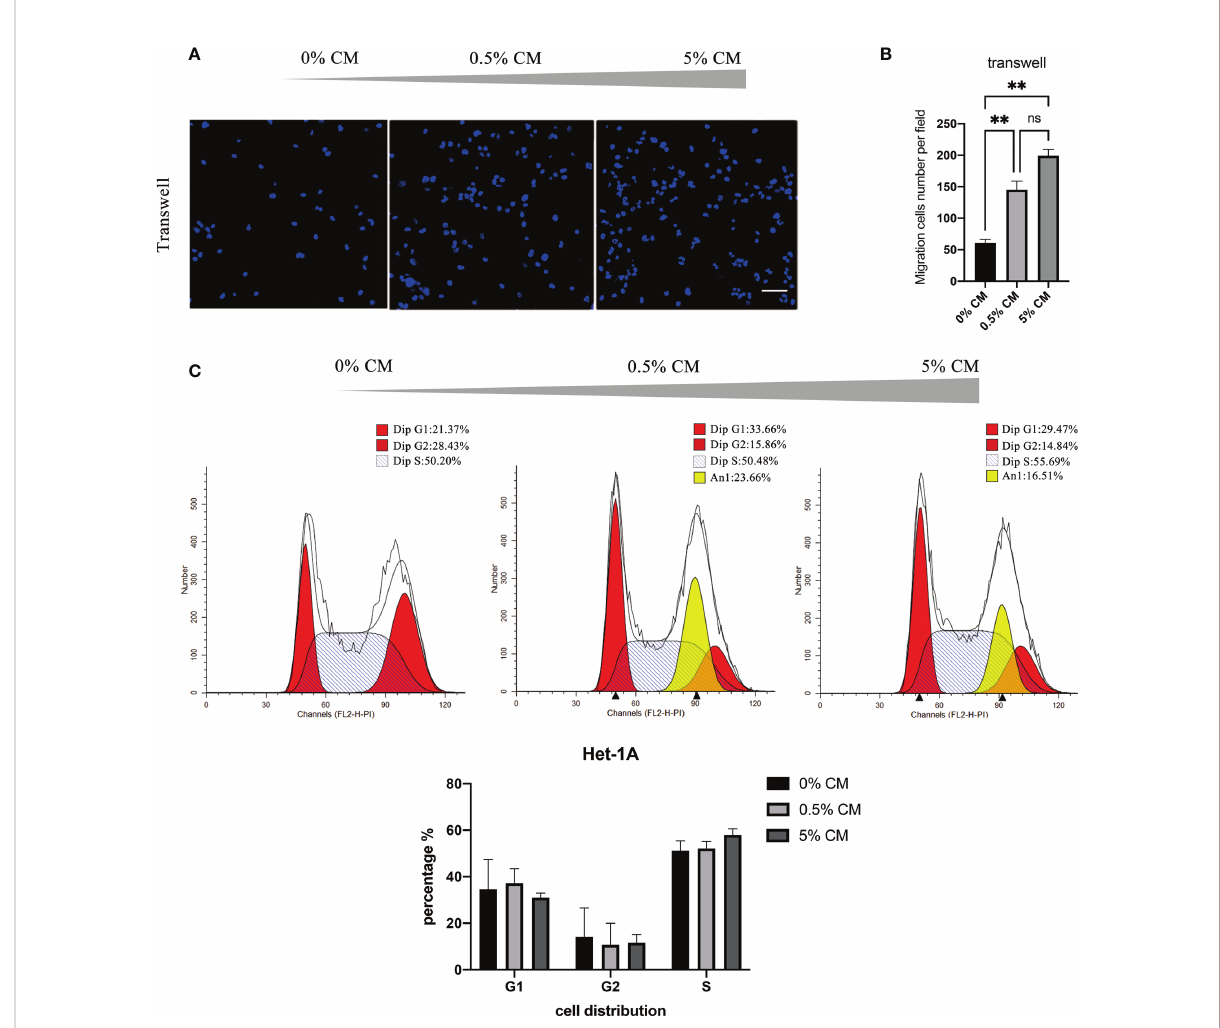
FIGURE 1 P . gingivalis cultured media promotes migration and proliferation of Het-1A cells. (A) Pictures of typical transwell assays. (B) Statistical analysis of transwell assay results. (C) Cell cycle analysis with propidium iodide staining. Scale bar: 100 m m. ** P < 0.01, ns, no statistical signi fi